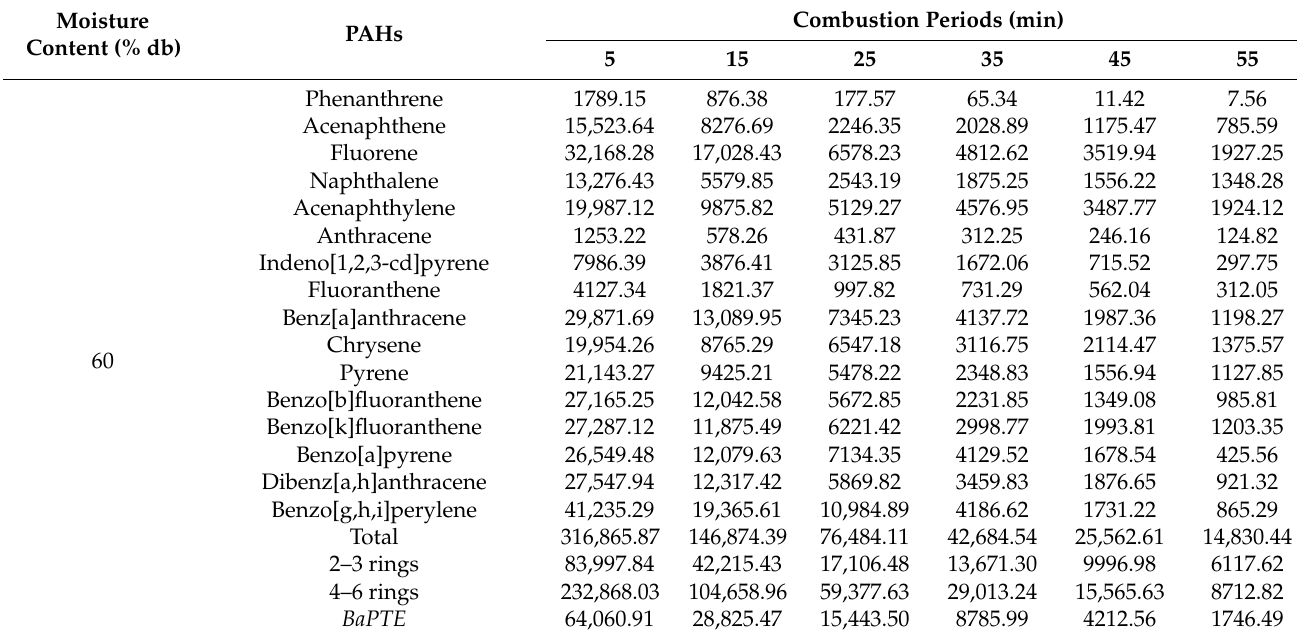
Figure 7. Total particle mass concentration emission from the POSS bio-char combustion for different moisture contents. Table 1. The PAH concentration components for different combustion periods at the highest palm oil sewage sludge